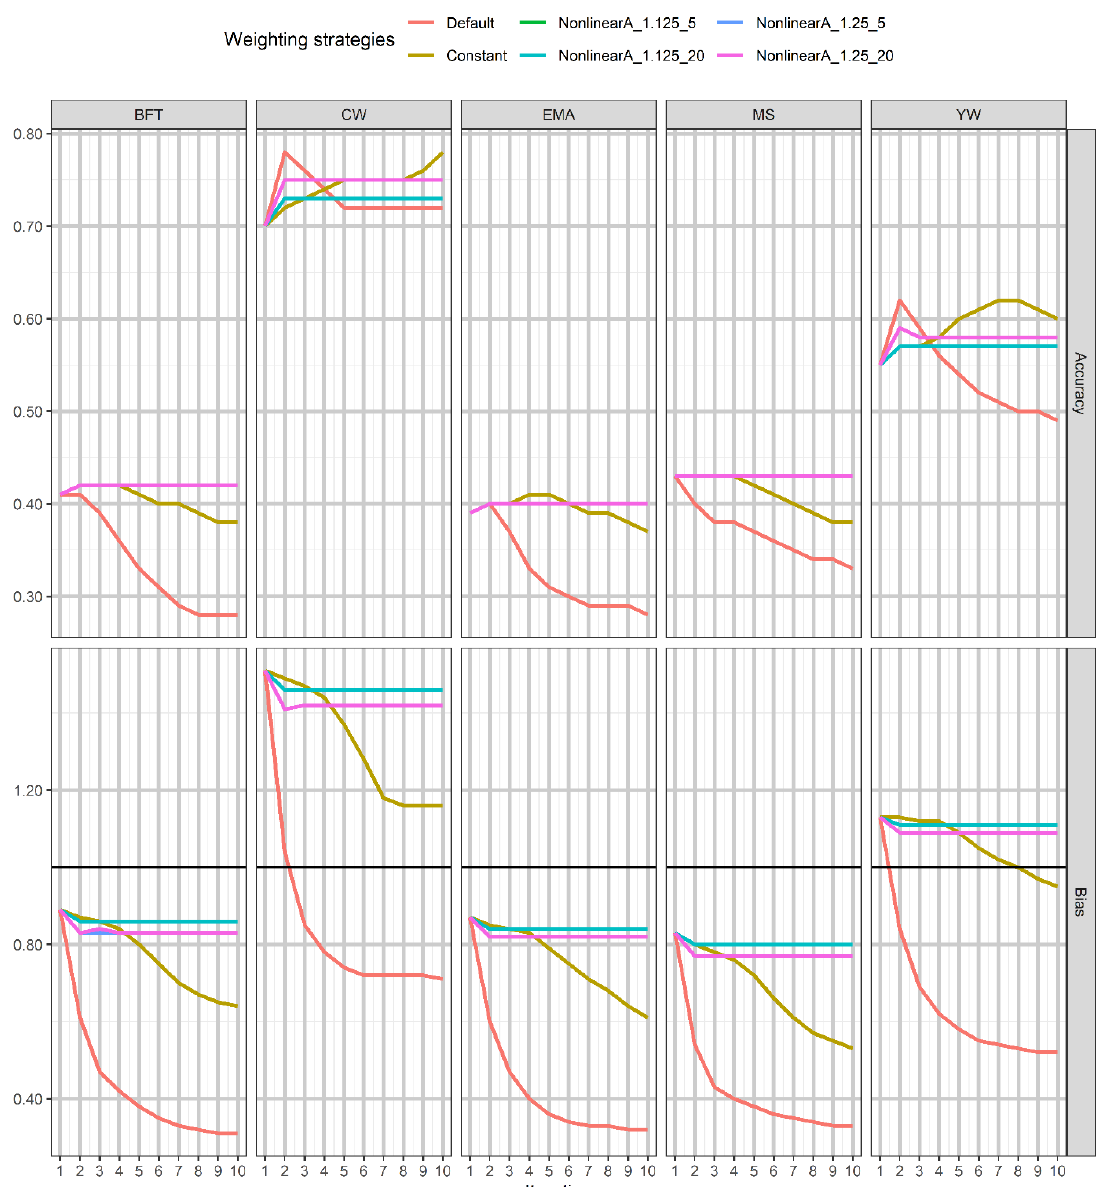
Figure 1. The trend in prediction accuracy and bias of genomic estimated breeding value (GEBV) was obtained using single weighting strategies across iterations for the studied traits. The CT (departure from normality) and exponent limits are shown as NonlinearA_CT_limit in Nonlinear A methods. BFT, backfat thickness; CW, carcass weight; EMA, eye muscle area; MS, marbling score; YW, yearling weight.